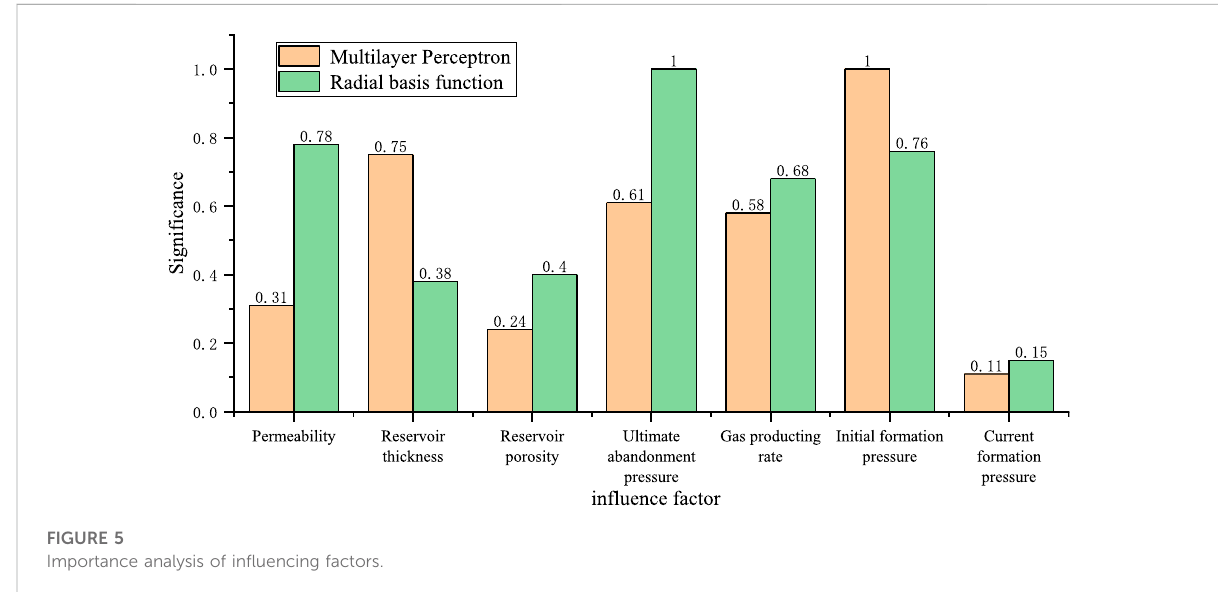
FIGURE 5 Importance analysis of in fl uencing